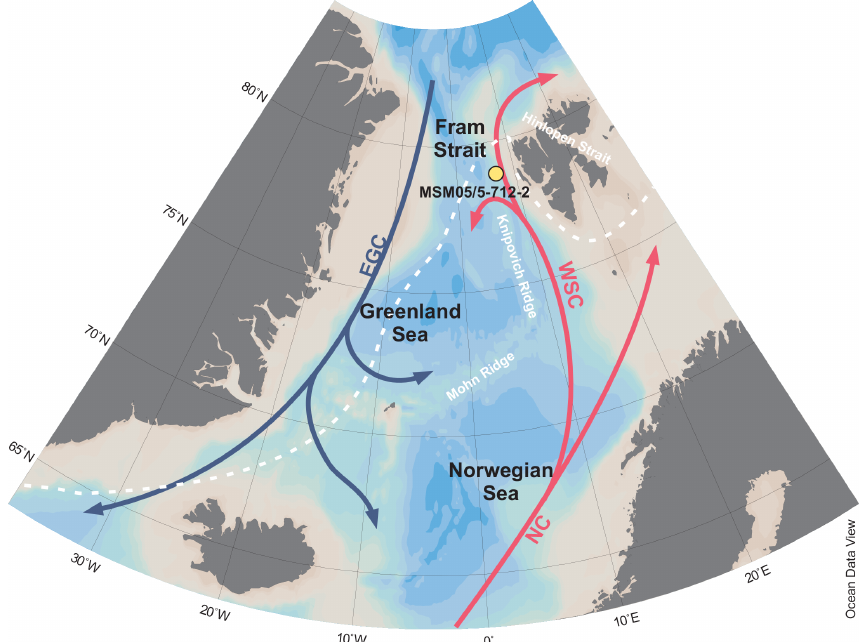
Figure 1. Map showing the coring site of MSM05/5-712-2 with bathymetric data derived from Ocean Data View (Schlitzer, 2018) and median March sea-ice extent from 1981 to 2010 (white, dashed line; https://nsidc.org/data/seaice_index/archives, last access: 6 August 2019; Fetterer et al.,